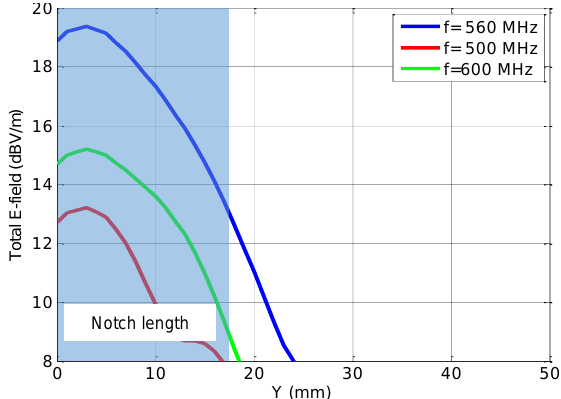
Figure. 13. Measured E-field (dB) along the notch at 500 MHz, 560 MHz and 600